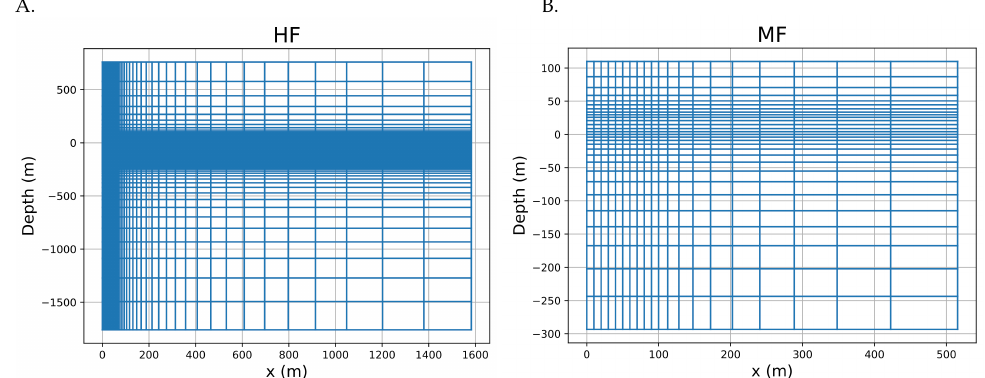
Figure A3. Cross-section of the 3D meshes used in this work, indicating regions with higher cell densities. ( A ) High-Fidelity (HF) mesh with 1,284,795 cells. ( B ) Medium-Fidelity (MF) mesh with 12,760